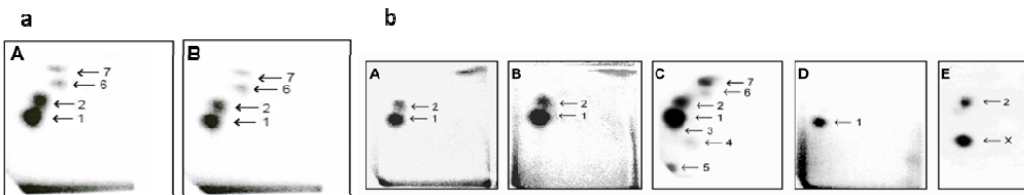
Figure 10. Autoradiographic profile of ³²P-labeled ellipticine-derived DNA adducts generated in UKF-NB-4 (aA) and SH-SY5Y (aB) cells. DNA adduct pattern generated in calf thymus DNA by ellipticine after its activation with CYP3A4 in the presence of NADPH without (bA) and with cytochrome b 5 (CYP3A4: cytochrome b 5 of 1:5) (bB) (42); DNA of male rat liver treated with 40 mg/kg body weight ellipticine (bC) (31); from calf thymus DNA reacted with 13-hydroxyellipticine (bD) (39) or 12-hydroxyelipticine (bE) (40). Analyses were carried out using the nuclease P1 enrichment version of the 32 P-postlabeling method. Adduct spots 1–7 correspond to the ellipticine-derived DNA adducts and were assigned as previously described [31].